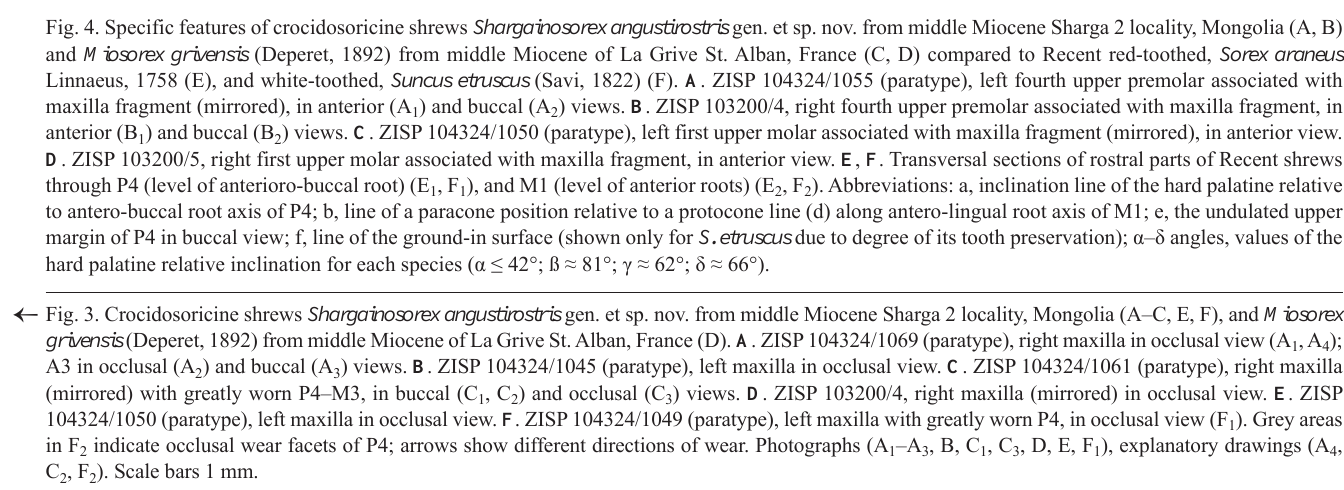
Fig. 3. Crocidosoricine shrews Shargainosorex angustirostris gen. et sp. nov. from middle Miocene Sharga 2 locality, Mongolia (A–C, E, F), and Miosorex grivensis (Deperet, 1892) from middle Miocene of La Grive St. Alban, France (D). A . ZISP 104324/1069 (paratype), right maxilla in occlusal view (A 1 , A 4 ); A3 in occlusal (A 2 ) and buccal (A 3 ) views. B . ZISP 104324/1045 (paratype), left maxilla in occlusal view. C . ZISP 104324/1061 (paratype), right maxilla (mirrored) with greatly worn P4–M3, in buccal (C 1 , C 2 ) and occlusal (C 3 ) views. D . ZISP 103200/4, right maxilla (mirrored) in occlusal view. E . ZISP 104324/1050 (paratype), left maxilla in occlusal view. F . ZISP 104324/1049 (paratype), left maxilla with greatly worn P4, in occlusal view (F 1 ). Grey areas in F 2 indicate occlusal wear facets of P4; arrows show different directions of wear. Photographs (A 1 –A 3 , B, C 1 , C 3 , D, E, F 1 ), explanatory drawings (A 4 , C 2 , F 2 ). Scale bars 1